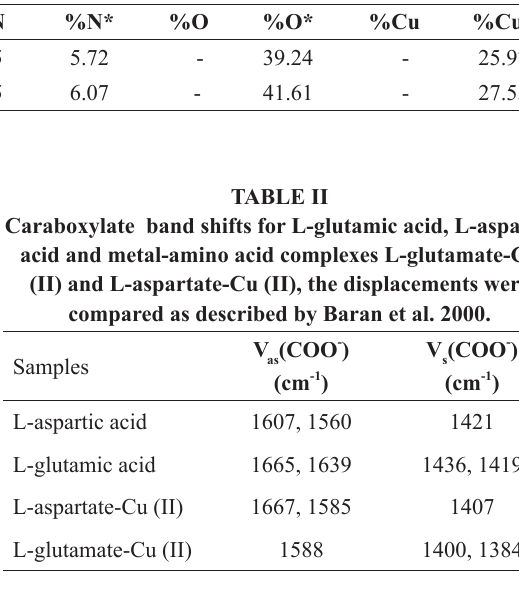
Theoretical and experimental values from elemental analysis for the L-glutamate-Cu (II) and L-aspartate-Cu (II) complexes.